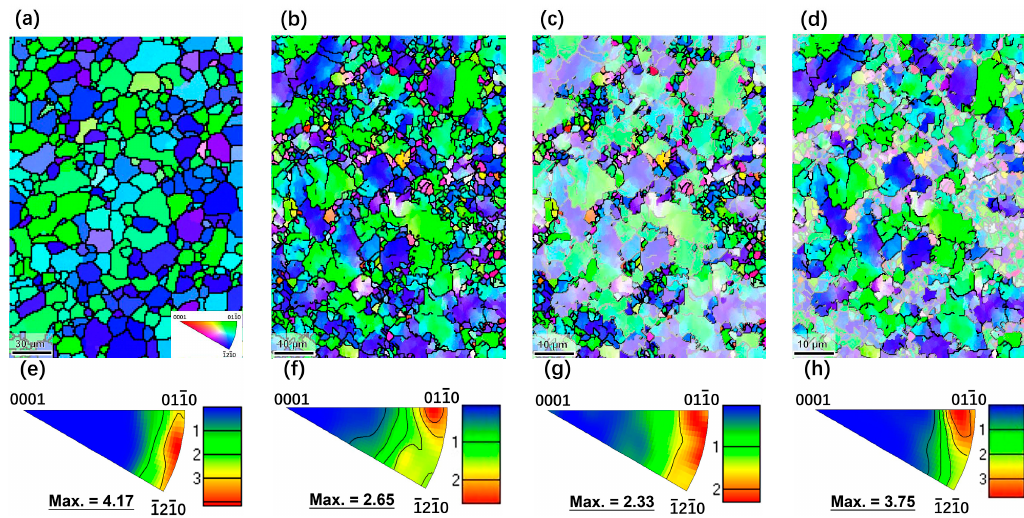
Figure 6. ( a – d ) Inverse pole figure (IPF) maps and ( e – h ) IPFs of ( a , e ) as-extruded and ( b – d , f – h ) CRed AZ80 alloy, respectively; ( b , f ) overall; ( c , g ) DRXed; ( d , h ) unDRXed regions of CRed AZ80 alloy.